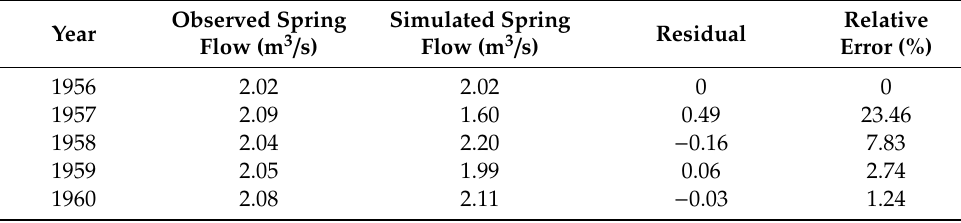
Table 3. Calibration for the GM (1,3) model with one-year and three-year